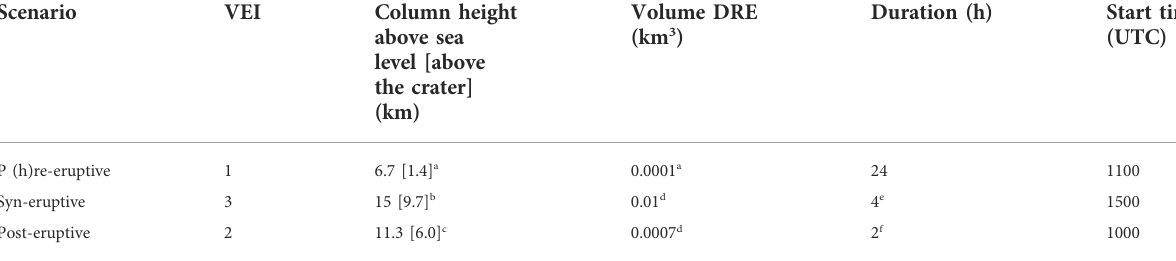
TABLE 2 Eruption source parameters for the simulations performed for the September 20, 2020 eruption of Sangay volcano.